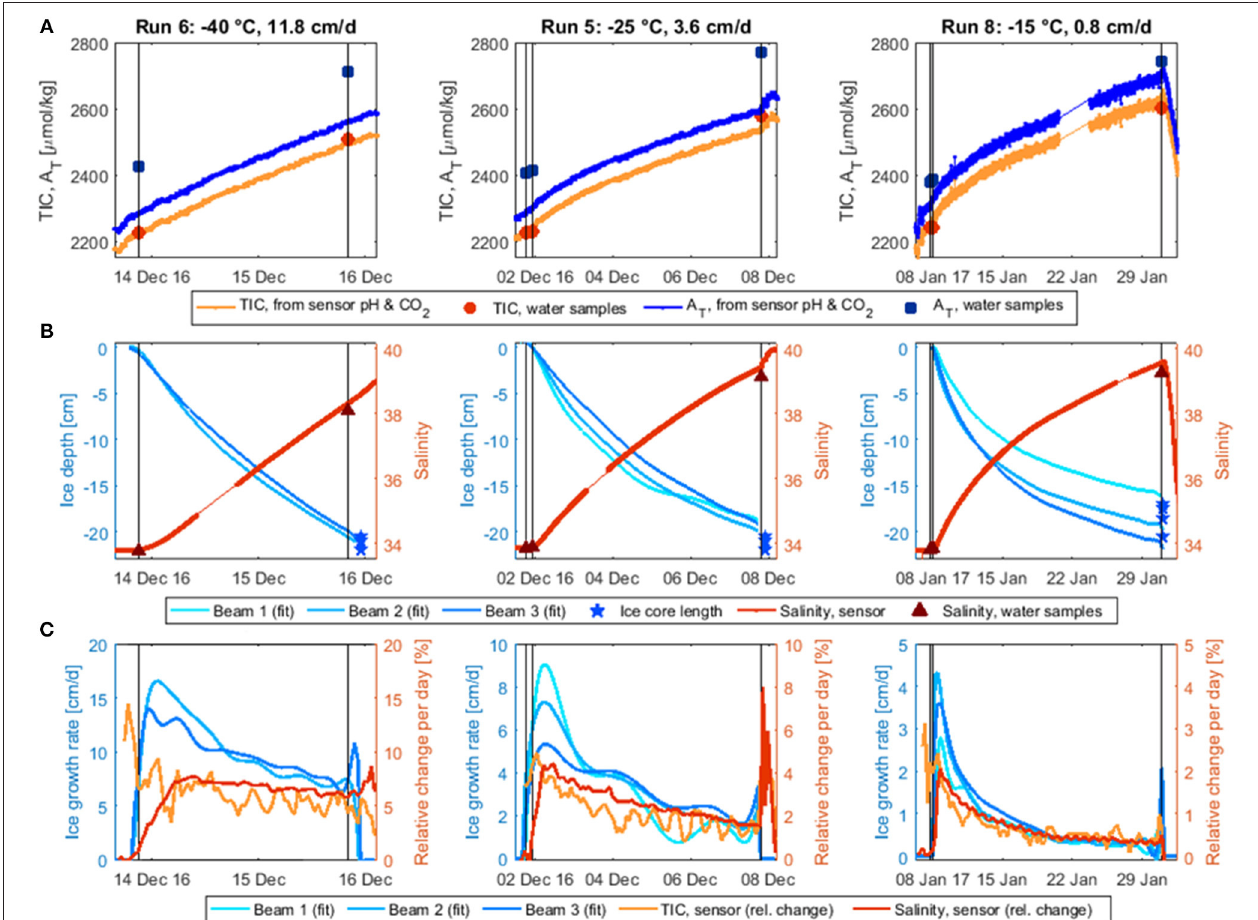
FIGURE 4 | Temporal development of water TIC, A T (A) , water salinity, and ice depth ( B ; fitted curves from the three Dopbeam sonars) during the three stirred experimental runs as well as the corresponding water sample measurements. TIC and A T were calculated from the HydroC p CO 2 and the (corrected) external pH of SeaFET 245. Water A T increased before the experiments started, possibly due to some electrochemical process associated with the sensors and equipment in the tank at initial deployment; note that seawater was added to the tank between runs 6 and 8 ( Table 1 ), reducing the relative impact of the alkalinity contaminant. (C) Ice growth rate (cm/d) derived from Dopbeam-measured ice depth and daily rates of change in salinity (dS/S per day) and TIC (dTIC/TIC per day). Note different vertical and horizontal scales. Black vertical lines indicate water